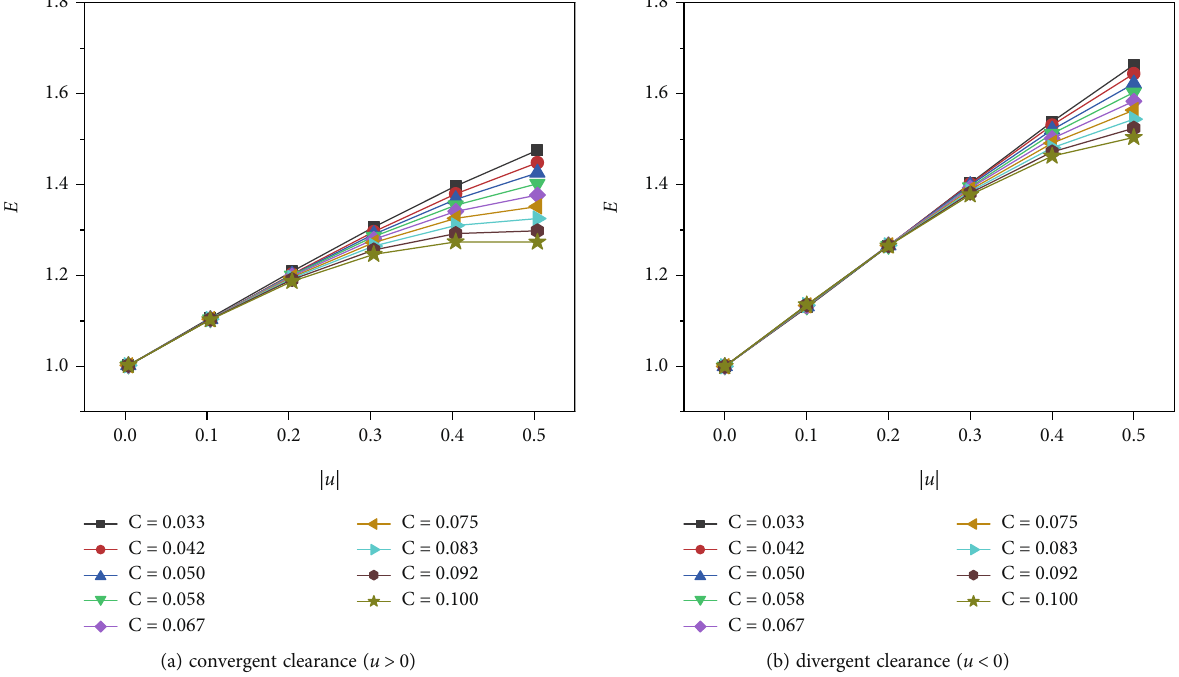
Figure 21: Variations of nonuniformity impact factor under di ff erent dimensionless minimum tip clearances ( Re = 10000 , π = 1 : 1 , = 0 : 23 M U